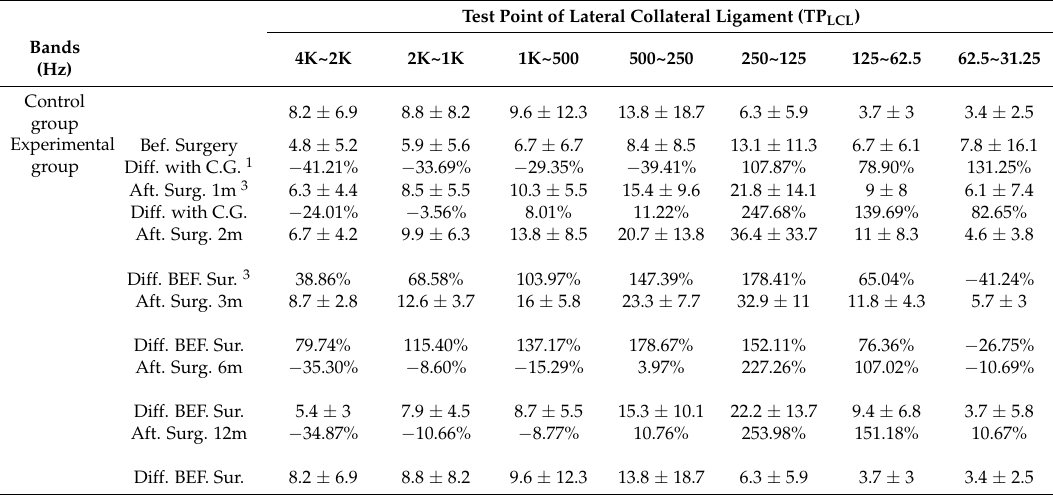
Table 3. Object average data of lateral collateral ligament between the control and experimental